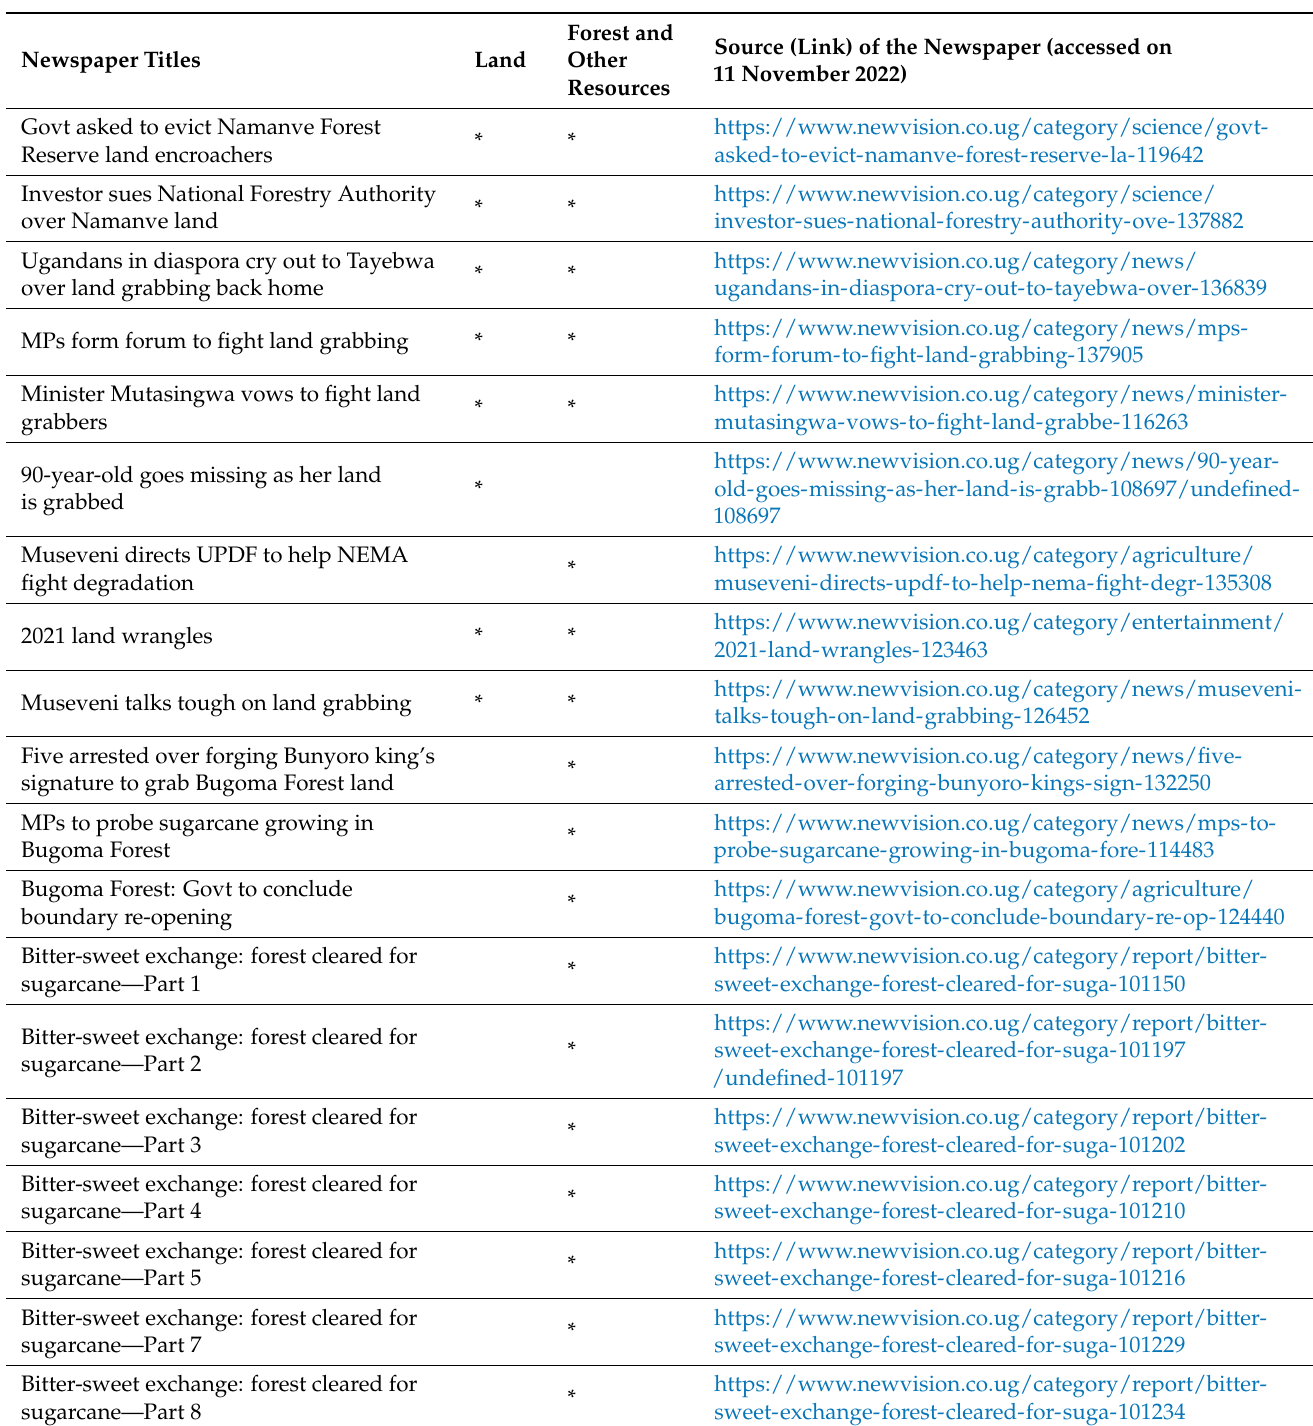
Table A1. Forest land grabbing and land grabbing in the major newspapers in Uganda (NewVision 2022 [48] and Monitor [49]). The * denotes conflicts on land and or Forest and other